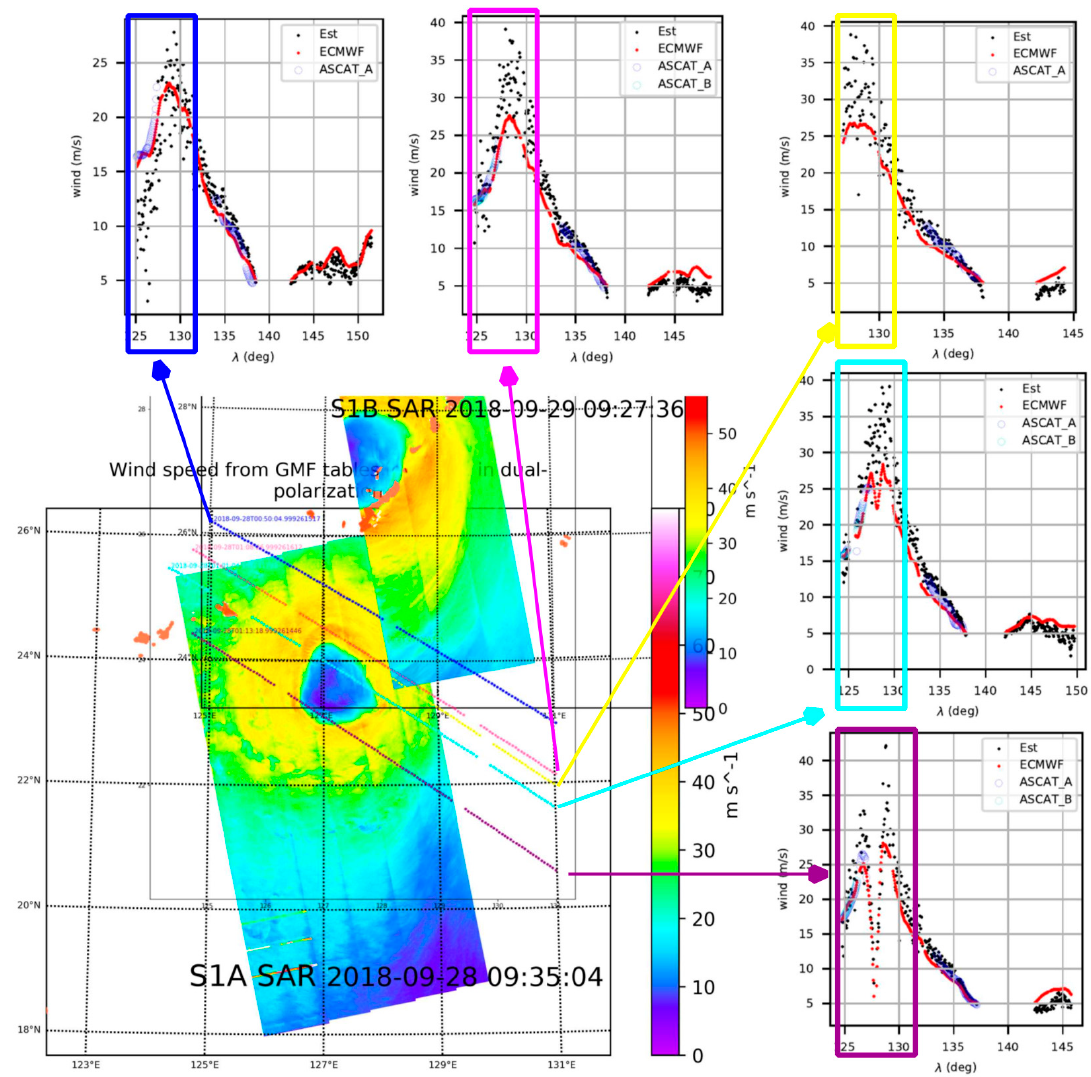
Figure 3. Sentinel-1A and -1B wind retrievals for Typhoon “Trami”, acquired on Sep 28 9:35 (lower) and Sep 29 9:27 (upper) 2018, approximately 24 h apart (from https://cyclobs.ifremer.fr, 3 April 2021). The colored tracks are CYGNSS passes ~8 h before the first Synthetic Aperture Radar (SAR) wind field image (Sep 28, between 00:50 and 01:26) when the eye was further South. The CYGNSS wind retrievals for each of the tracks, estimated by A. Rius et al. [22], are shown in black dots (“Est” legend) in the panels surrounding the images. The red dots are for European Centre for Medium-Range Weather Forecasts (ECMWF) ERA-5 wind speeds interpolated to the CYGNSS tracks, and Advanced SCATterometer ASCAT-A/B are shown in blue circles when co-located.